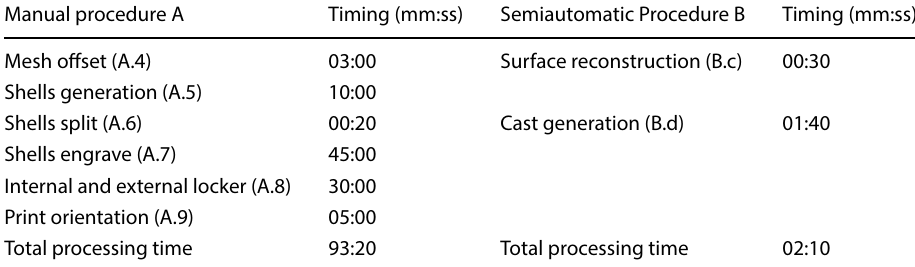
Table 2 Processing phases design timing comparison